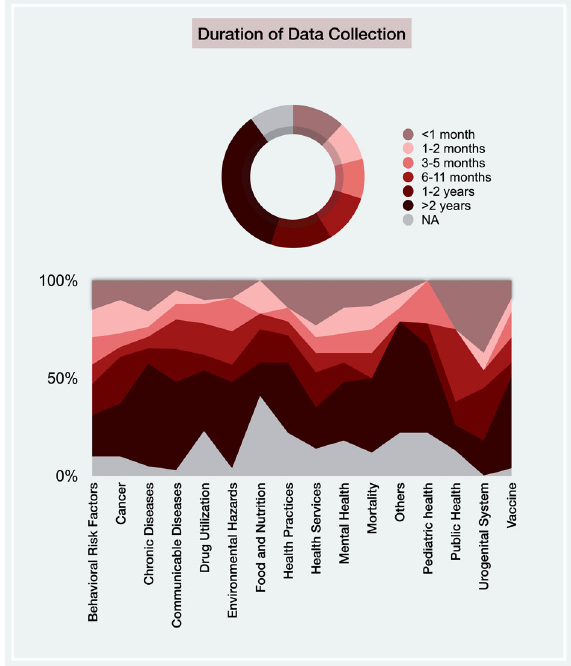
Fig. 5 Data collection duration. The differences in data collection duration across included studies and the proportion of articles within each time frame across all surveillance